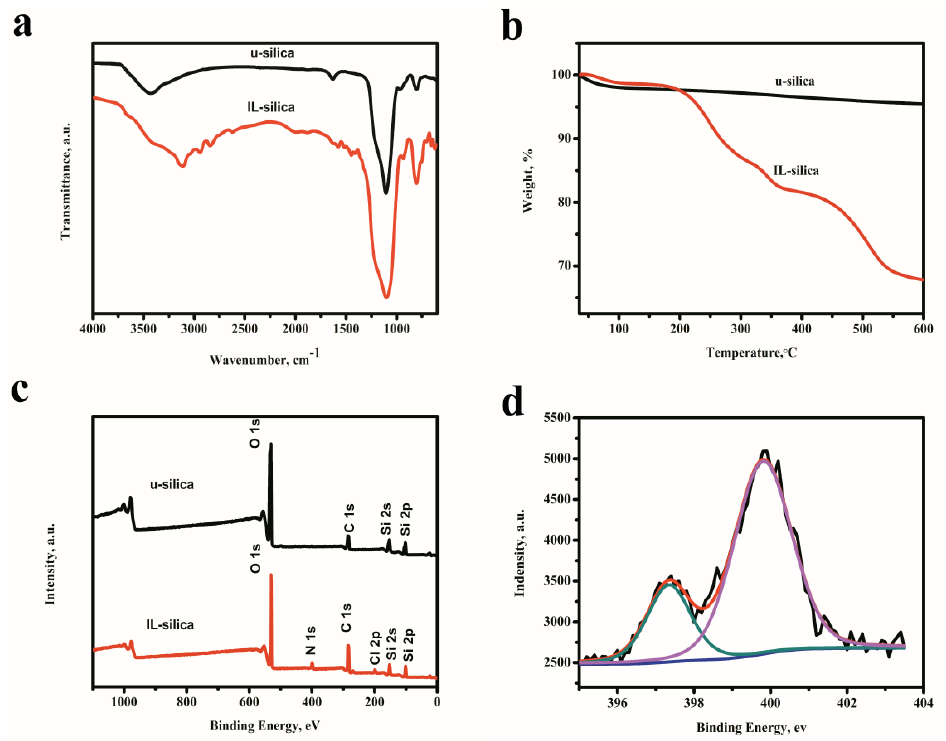
Figure 2. Characterization of ( a ) Fourier transform infrared (FT-IR) spectroscopy; ( b ) Thermogravimetric analysis (TGA) curves; ( c ) X-ray photoelectron spectroscopy (XPS) broad scan spectra; and ( d ) XPS N 1s curves of silica and IL-silica.